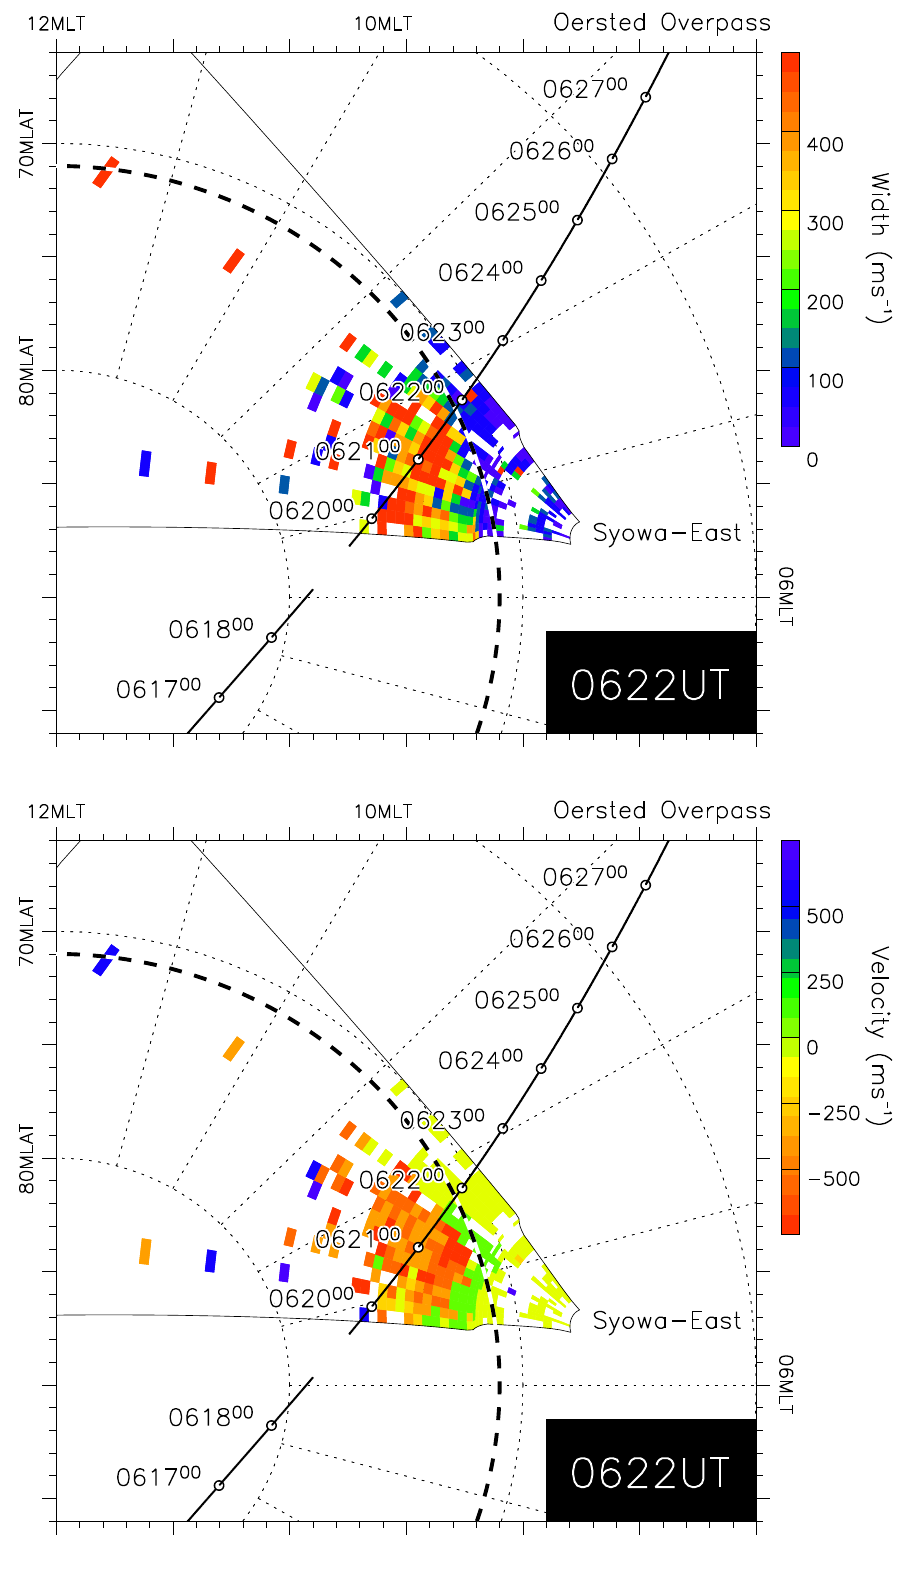
Fig. 2. Maps of spectral width (top) and line-of-sight Doppler velocity (bottom) as observed by all of the beams of the SENSU Syowa East radar at 06:22 UT in a magnetic latitude and magnetic local time coordinate system. Overlaid black line represents the footprints of the Oersted spacecraft mapped down to the altitude of the SuperDARN observations using the Tsyganenko 96 model. Dotted circle traces an approximate location of the spectral width